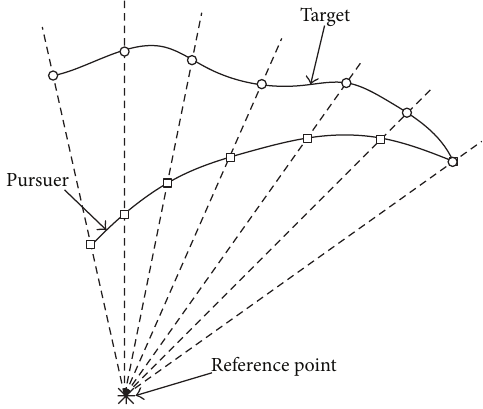
Figure 2: Motion camouflage